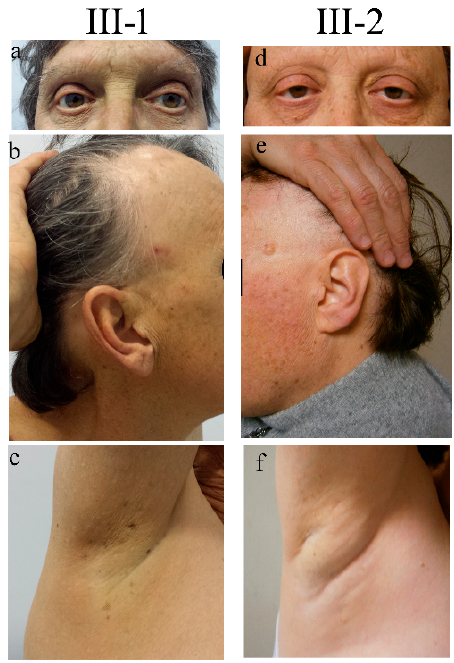
Figure 1. Clinical signs in two siblings carrying NUP98 alterations. Representative pictures documenting the same signs both in the male (III-1) and the female (III-2) patients: ptosis and absence of eyelashes and eyebrows ( a , d ), sparse hair and mottled pigmentation on the face ( b , e ), and absence of ancillary hair ( c , f ). Pictures were taken when patients III-1 and III-2 were 55 and 52 years old, respectively.